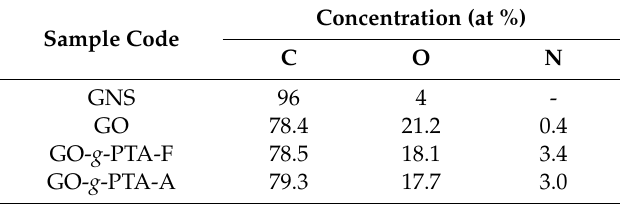
Table 1. Surface atomic concentrations in GNS, GO, GO- g -PTA-F, and GO- g